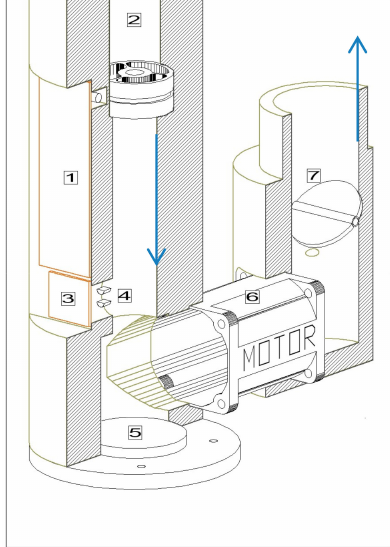
Figure 2. Diagram of the flow generator and control systems: flow control board (1), anemometer (2), T and RH control board (3), T and RH sensor (4), water drainage (5), motor and fan (6), manual air flow shutter (7). The arrows denote the flow